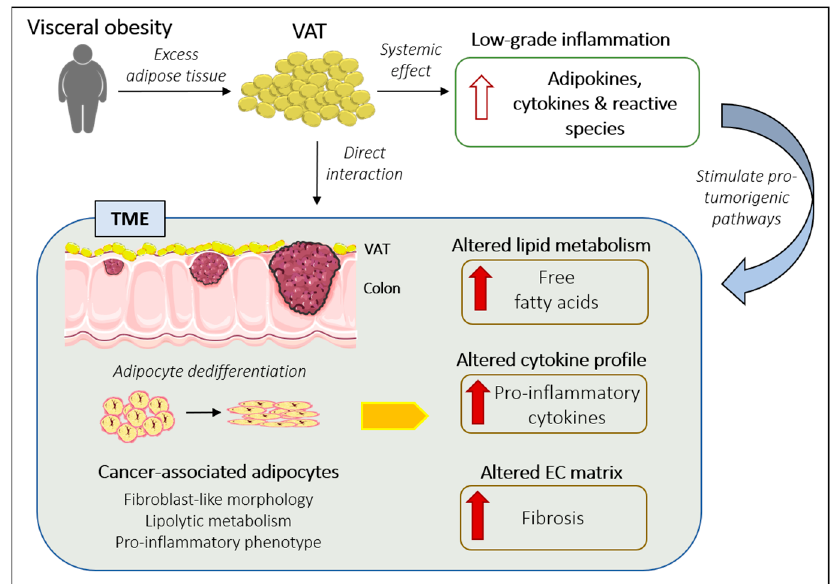
Figure 2. Summary figure which explains the potential relationship between VAT and CRC development and progression. EC: extracellular; TME: tumor microenvironment; VAT: visceral adipose tissue.